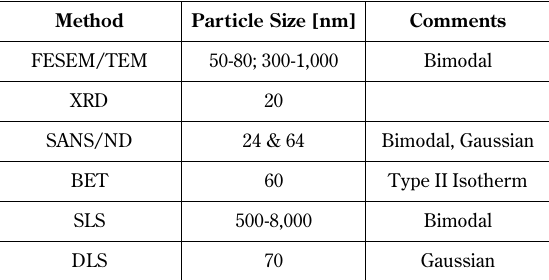
Table I Summary of Methods and